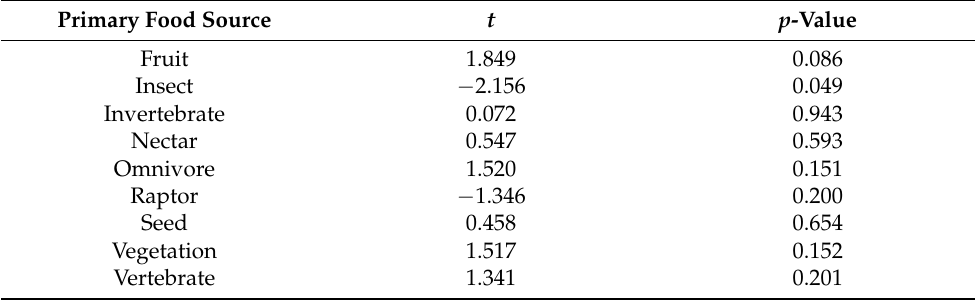
Table 6. Results of paired t -test for difference in the proportion of bird species by primary food source between 1998 and 2018 in areas where greenspace has decreased (df = 14). Primary Food Source t